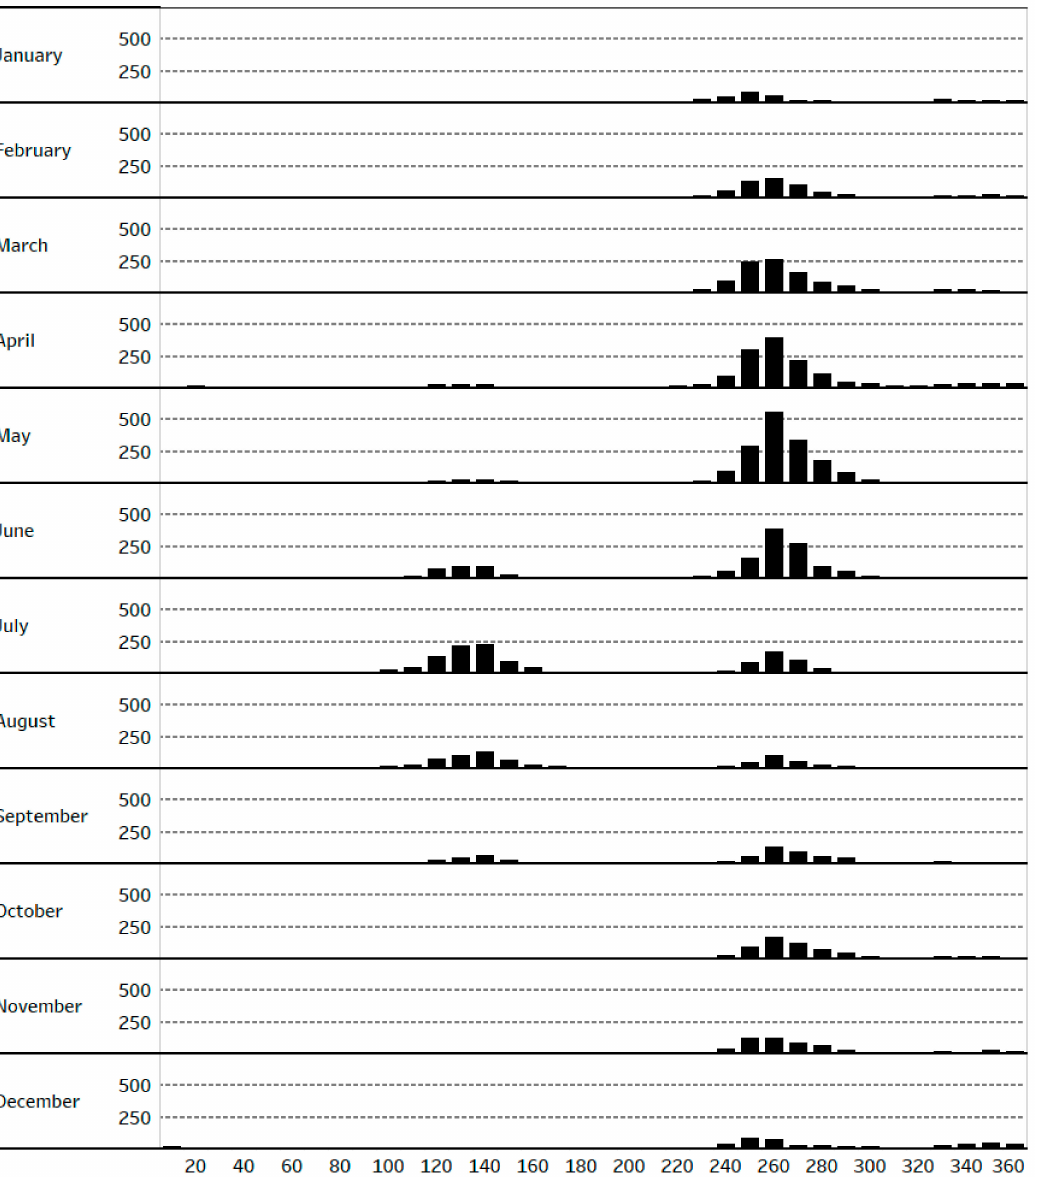
Figure 2. Monthly wind direction histograms of hours when wind speed is greater than 10 mph, as measured at the Imperial County Municipal Airport (KIPL). Data period 2010 to 2017. Plots of daily PM2.5 versus wind speed at each gravimetric site are shown in Figure 5. Consistent with PM10, concentrations are higher at Brawley than El Centro and Calexico. Concentrations often exceed 20 µ g / m 3 at Brawley with the highest value reaching around 60 µ g / m 3 but rarely exceeding 20 µ g / m 3 at El Centro and Calexico. The daily PM2.5 is positively correlated with wind speed at all sites, however with lower r 2 as compared with PM10. This is consistent with the weaker association of PM2.5 with windblown dust as compared with